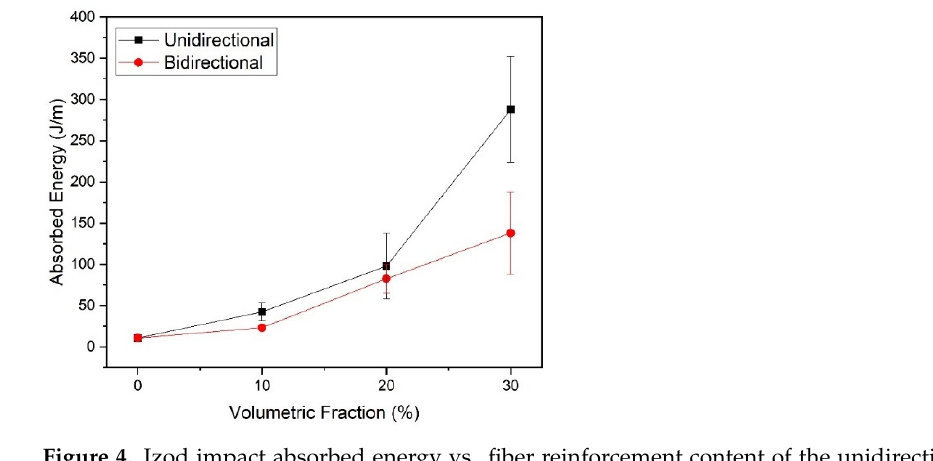
Figure 4. Izod impact absorbed energy vs. fiber reinforcement content of the unidirectional and bidirectional specimens.